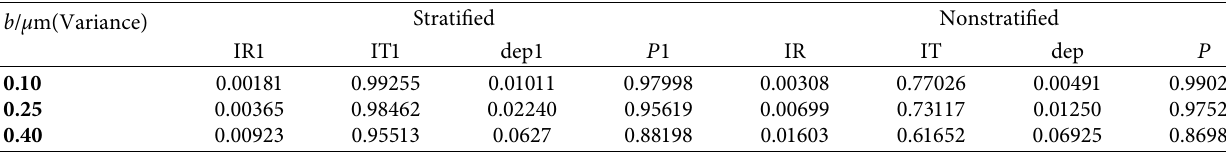
Figure 6: Circularly polarized laser [1, 0, 0, − 1] (in a completely left-hand circularly polarized state) transmitted in the Martian dust: (a) horizontal component of circularly polarized laser [1, 0, 0, − 1] varying with the transmission distance and (b) vertical component of circularly polarized laser [1, 0, 0, − 1] varying with the transmission distance. Table 4: Comparison table of polarization parameters (stratified and nonstratified).